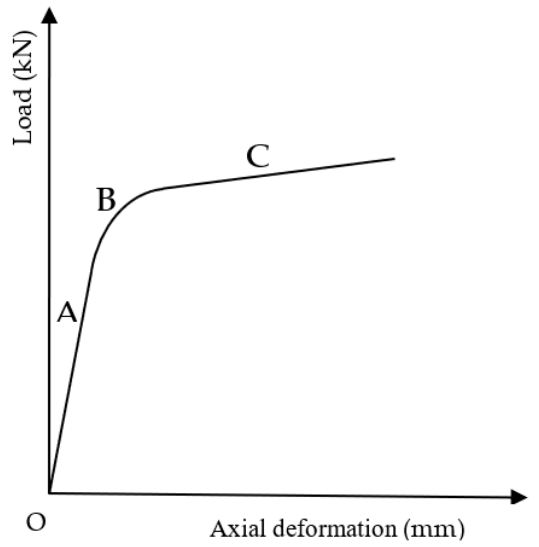
Figure 7. The axial load–deformation model curve of CFSTs. A—the elastic stage; B—the elastoplastic stage; C—the strengthening stage.